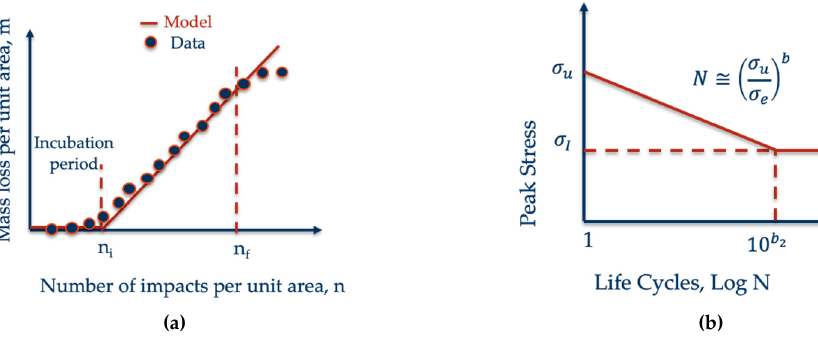
Figure 5. ( a ) Evolution of weight loss on experimental rain erosion testing coupons and lifetime prediction model defining the incubation period and mass removal rate ( b ) Springer Model based Fatigue life N approximation related with the material ultimate strength σ u , the parameter “erosion strength”, σ e and the parameter b that includes the fatigue knee at the endurance limit σ I . Adapted from: [13].